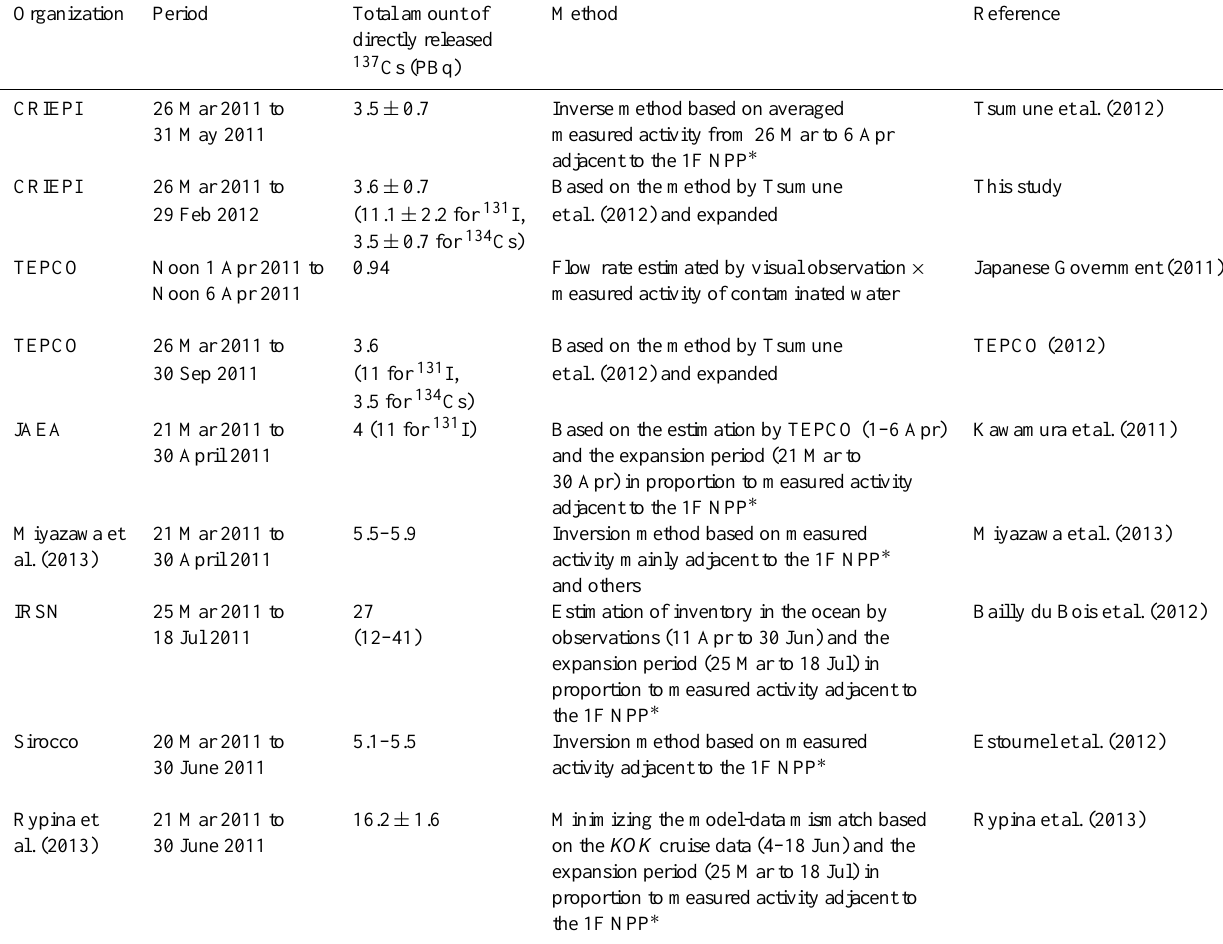
Table 1. Estimated total amount of 137 Cs activity directly released into the ocean by release scenario. Organization Method